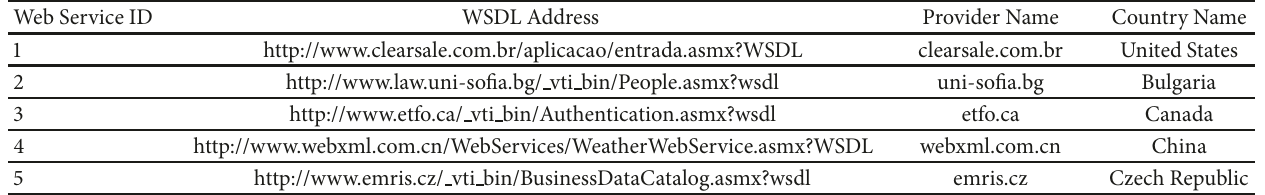
Figure 4: An illustration of LANFM model. Table 1: Original location information of Web service.